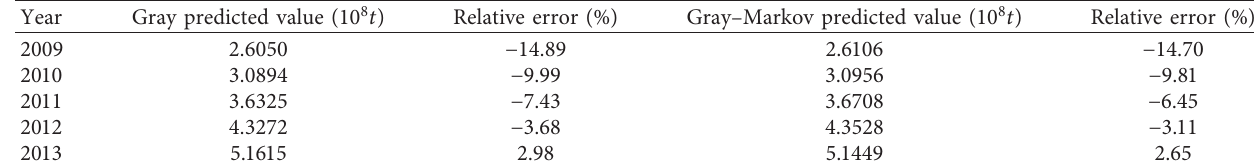
Table 5: Predicted value comparison between the Gray GM (1, 1) model and Gray–Markov model. Year Gray predicted value (10 8 t ) Relative error